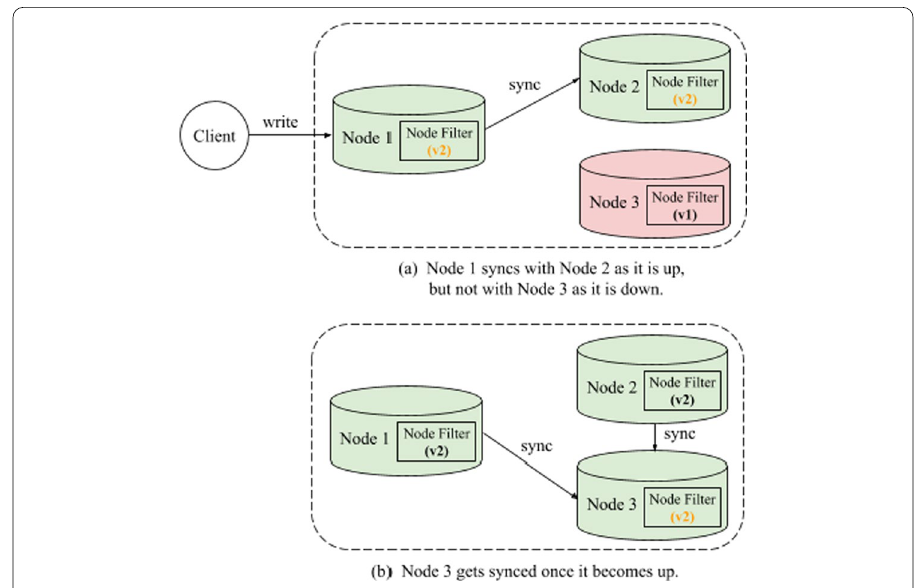
Fig. 21 Proper way to synchronize node filter in peer-to-peer distributed architecture